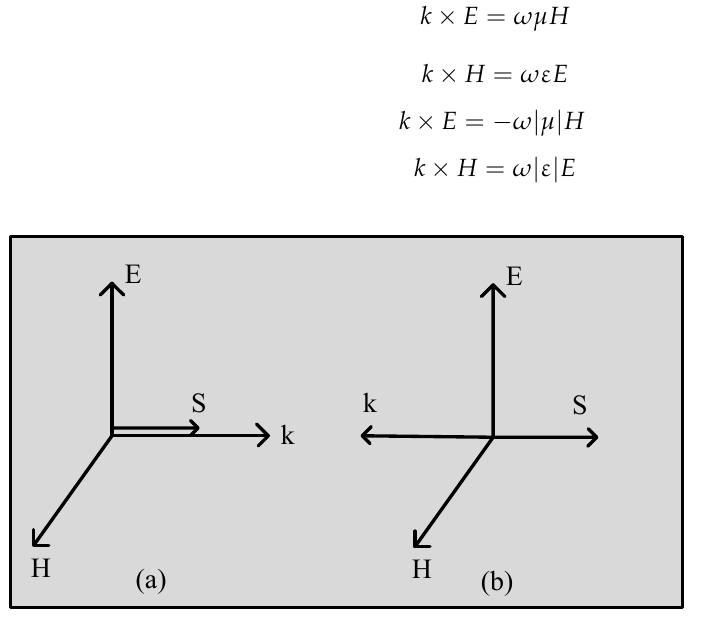
Figure 1. Classification of metamaterial by sign of